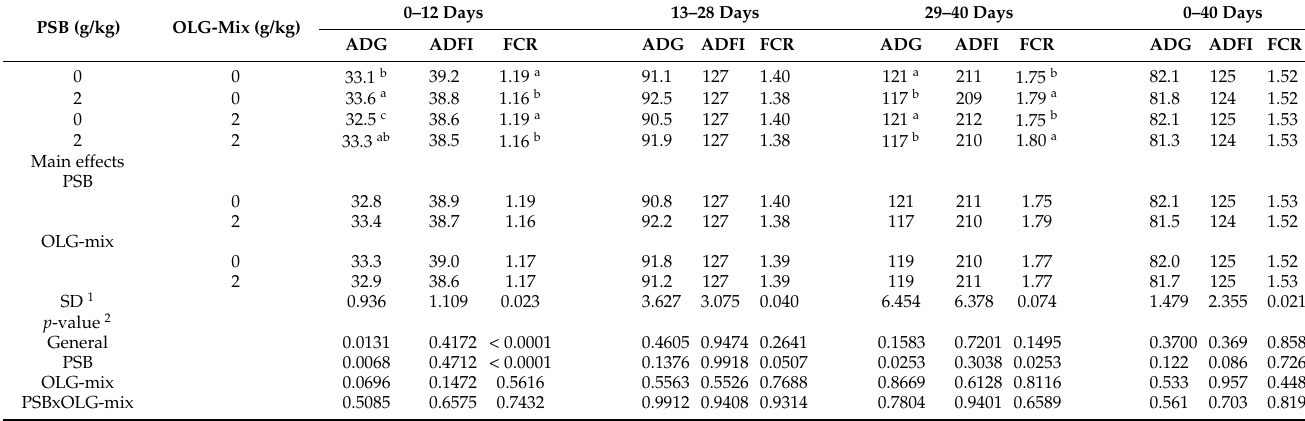
1 SD: standard deviation ( n = 30 replicates for each main effects, n = 15 replicates for the interaction). 2 p :